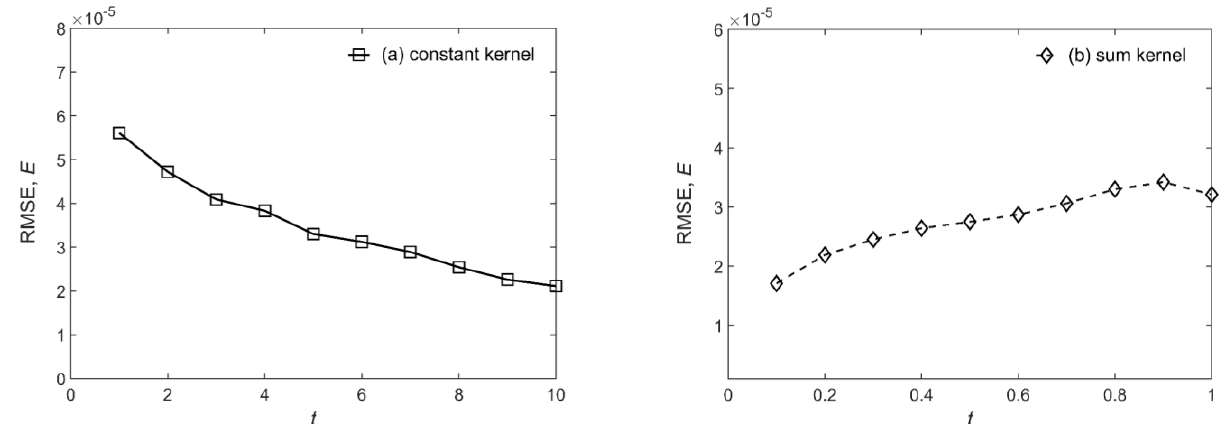
Figure 2. Temporal evolution of RMSE values between the RBF method and the analytical solu- tions: ( a ) constant kernel coagulation; ( b ) sum kernel